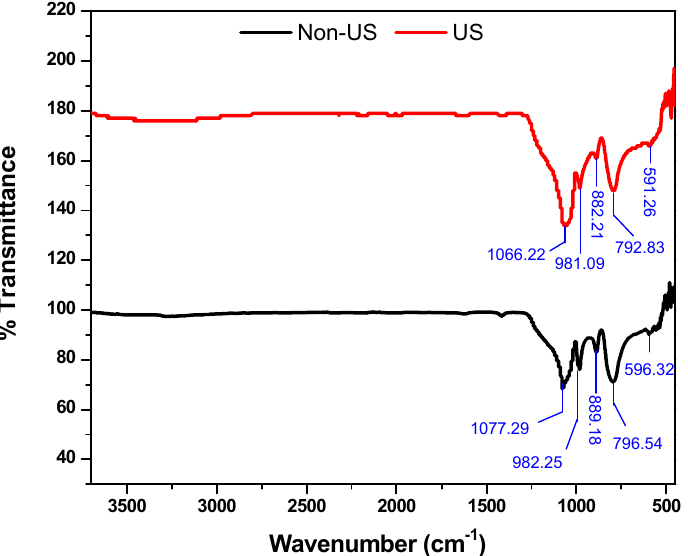
Figure 1. FT-IR analysis of the ultrasonically and non-ultrasonically synthesized 1%Pd-HPW/SiO 2 bi-functional catalysts .